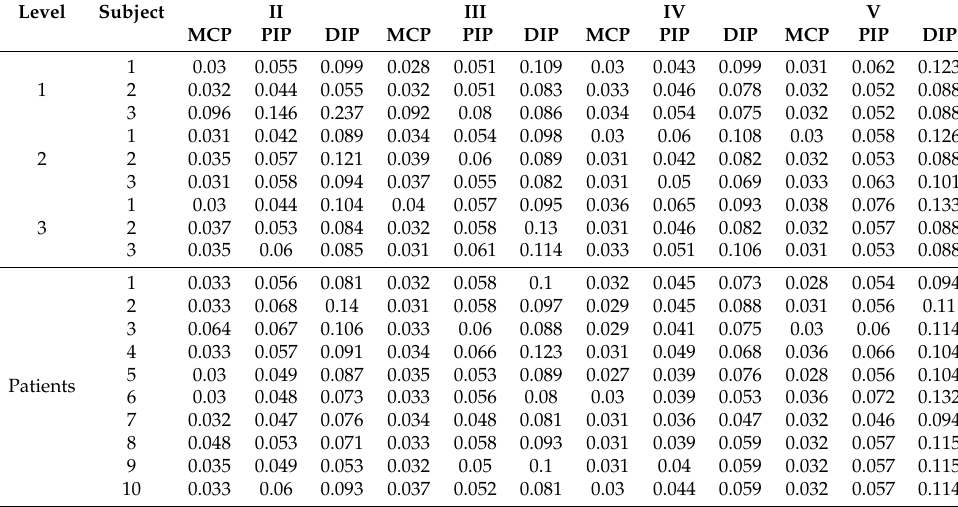
Figure 6. Low-level on-off position controller to drive the linear actuators of the exoskeleton for simulation (red lines) and experiments (blue lines). The first row corresponds to the actuator displacement x act , the second row to the on-off control output, the third row to the Cartesian position of the fingertip, and the last two rows to the joint positions (MPC, PIP, and DIP). Table 3. Discontinuity of the joint angular position for fingers II–V, calculated for the 10 patients in the first dataset and the 3 additional subjects with 3 muscular